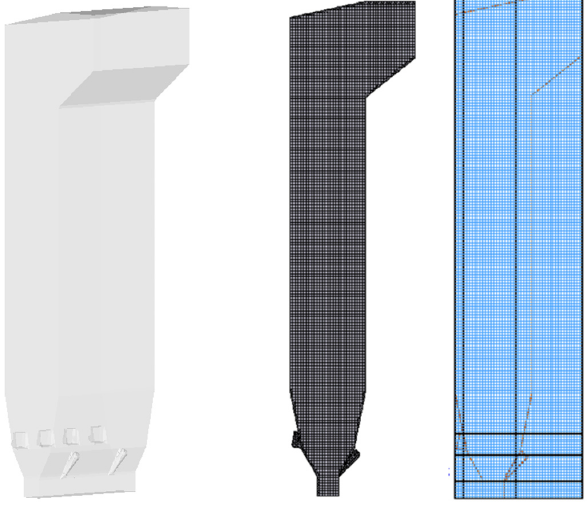
Figure 1. Model setup and grid generation of the biomass CFBB.